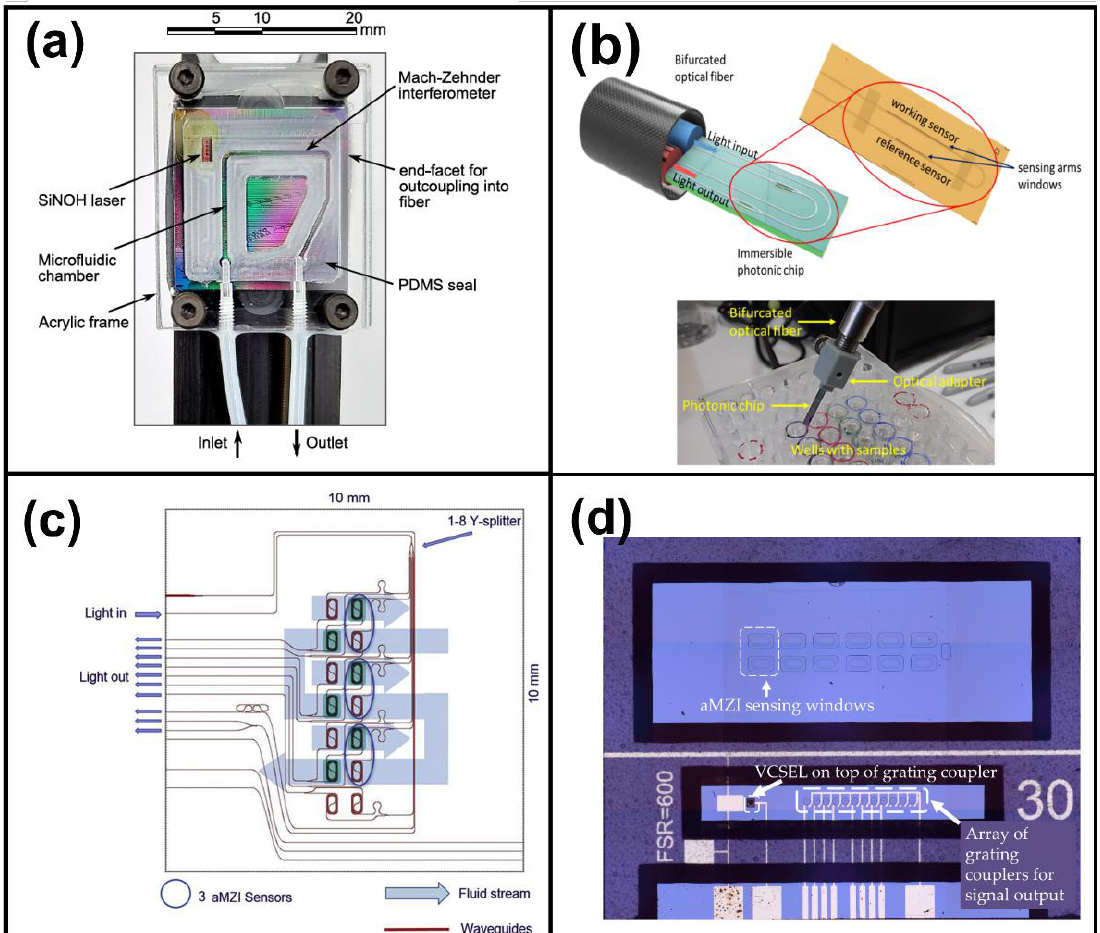
Figure 3. Integration of MZIs for multiplexed measures. ( a ) SiNOH laser integration in a photonic chip inside a microfluidic cartridge for biosensing applications. ( b ) Directly immersible MZI im- munosensor without the need for a microfluidic cartridge and flow delivery system. ( c ) Overview of a multiplexed sensor, showing the full integration of light in- and out-coupling and the fluid stream for the measures of four MZIs at the same time. ( d ) Microscope photograph of MZI chip with hybrid inte- gration of vertical-cavity surface-emitting laser (VCSEL) and photodiodes for multiplexed measures. ( a ) Reprinted with permission from ref. [51], copyright 2022, Elsevier; ( b ) reprinted with permission from ref. [52], copyright 2022, Elsevier; ( c ) reprinted with permission from ref. [53], copyright 2019, Elsevier; ( d ) reprinted with permission from [54], copyright 2019,